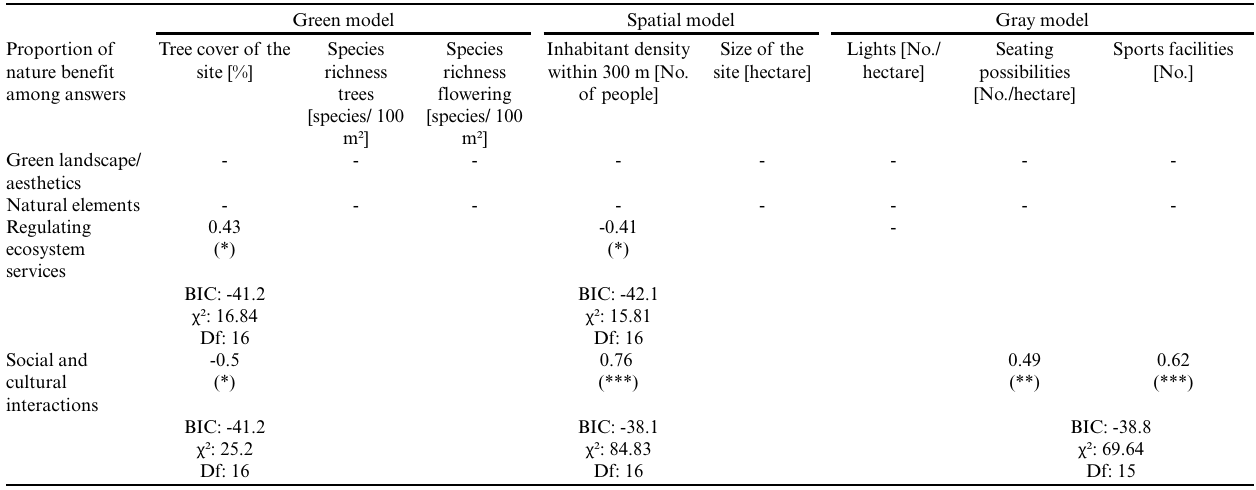
Table 2 . Results from separated generalized linear models (quasibinomial family) for green, spatial, and gray urban green space characteristics and four positive categories that represent nature benefits. Only significant coefficients (* < 0.05, ** < 0.01, *** < 0.001) of the best model (lowest BIC) within each structural dimension after Bayesian Model averaging are shown. The chi-square value specifies the difference in deviance between the model and the null-model, Df indicates degrees of freedom. Green model Spatial model Gray